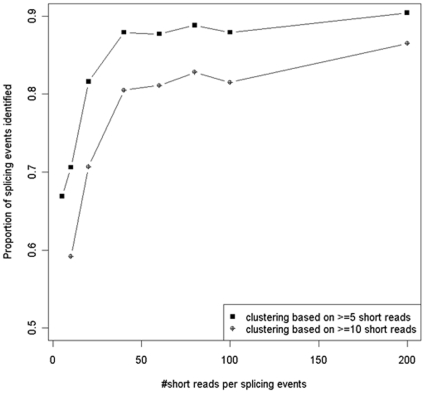
The increase of the proportion of splicing events identified by SAW with increasing number of short reads per splicing event.Results are based on short read clusters with minimum size of 5 and 10.